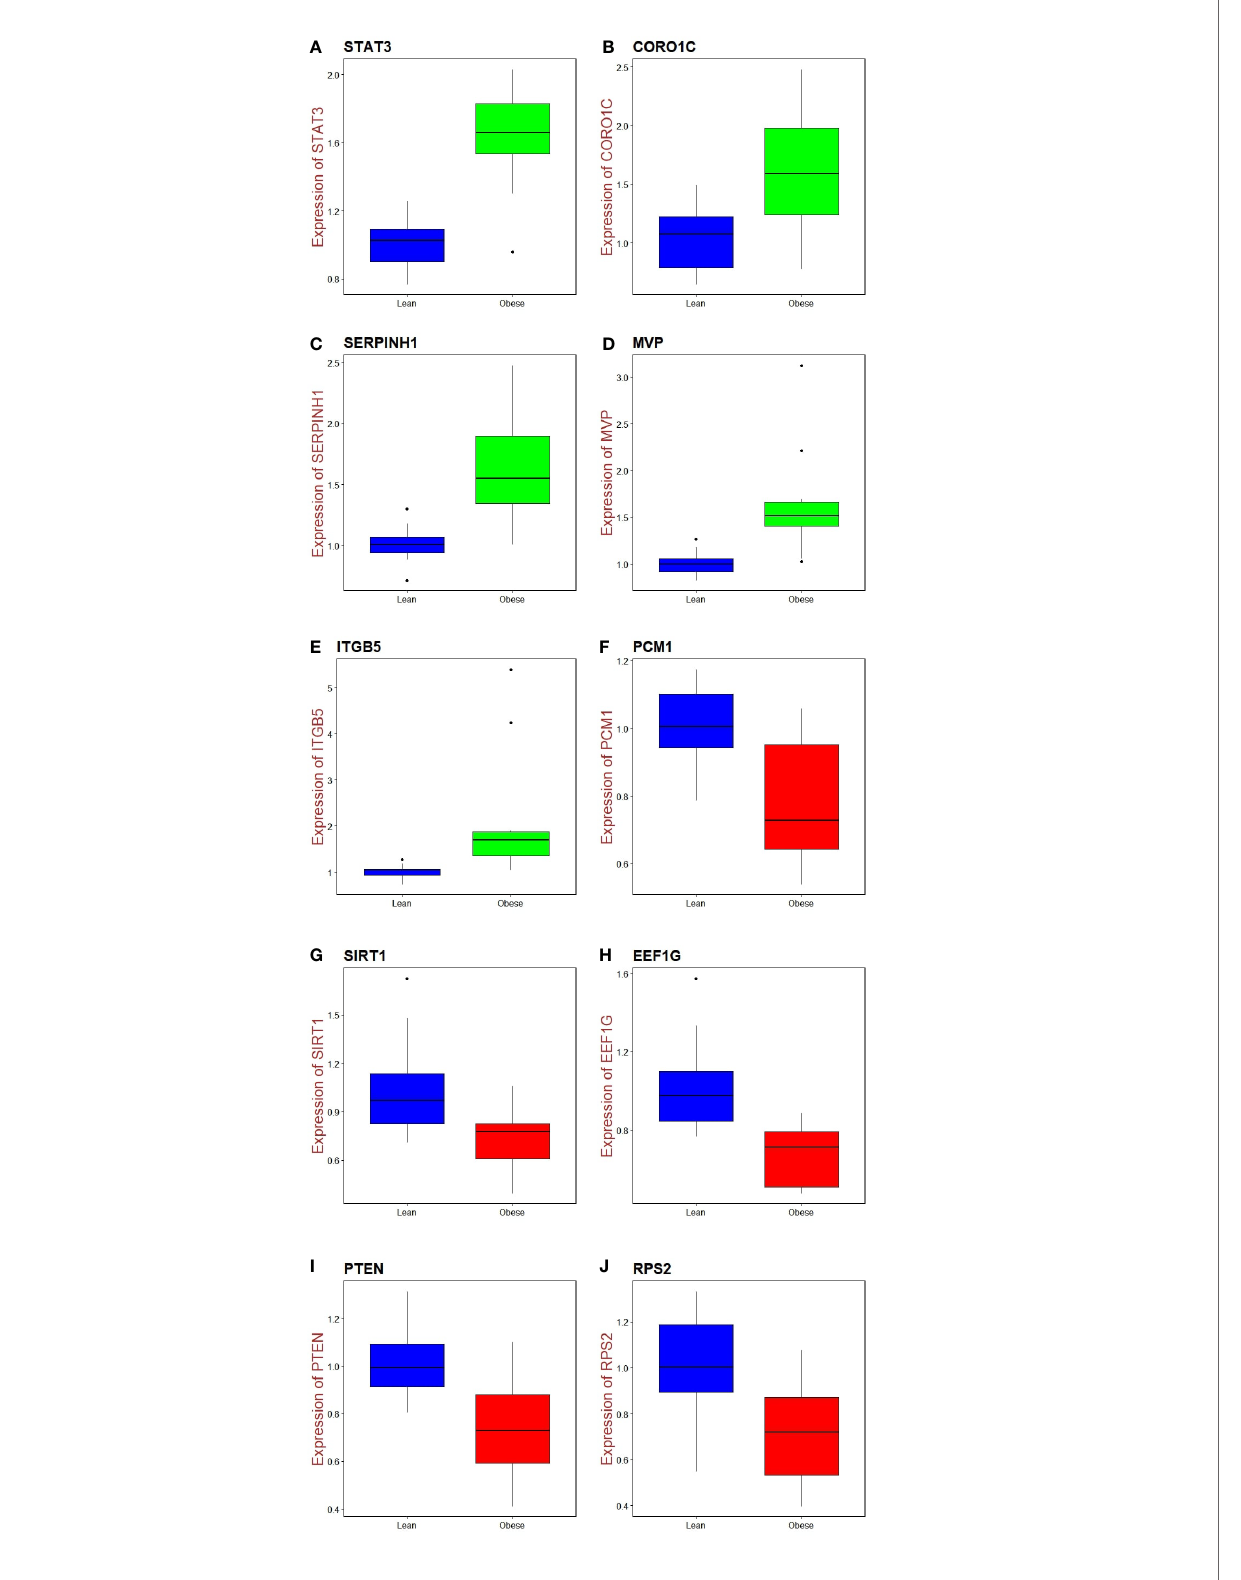
FIGURE 13 | Validation of hub genes by RT- PCR. (A) STAT3 (B) CORO1C (C) SERPINH1 (D) MVP E) ITGB5 (F) PCM1 (G) SIRT1 (H) EEF1G (I) PTEN (J)